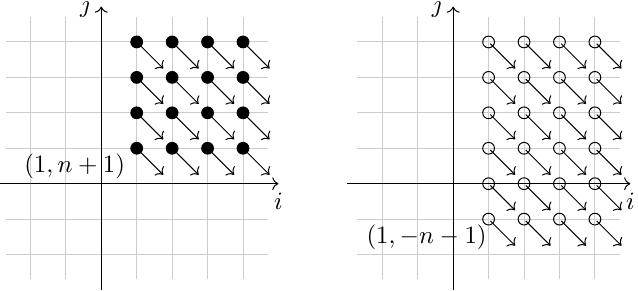
Figure 6 . Pictorial representation of the coe(cid:14)cients of t 2 n , n (cid:21) 0, coming from the two terms in (B.25).